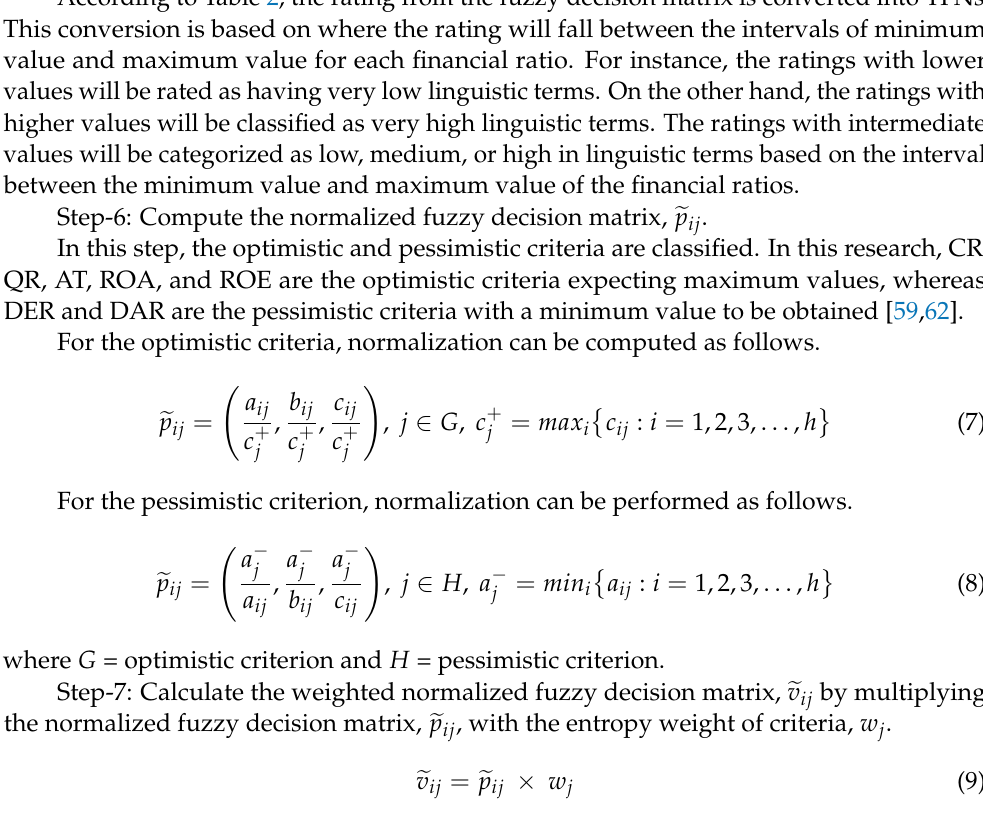
Table 2. Linguistic variables corresponding to TFNs. Linguistic Terms TFNs Very low 1, 1, 3 Low 1, 3, 5 Medium 3, 5, 7 High 5, 7, 9 Very high 7, 9,